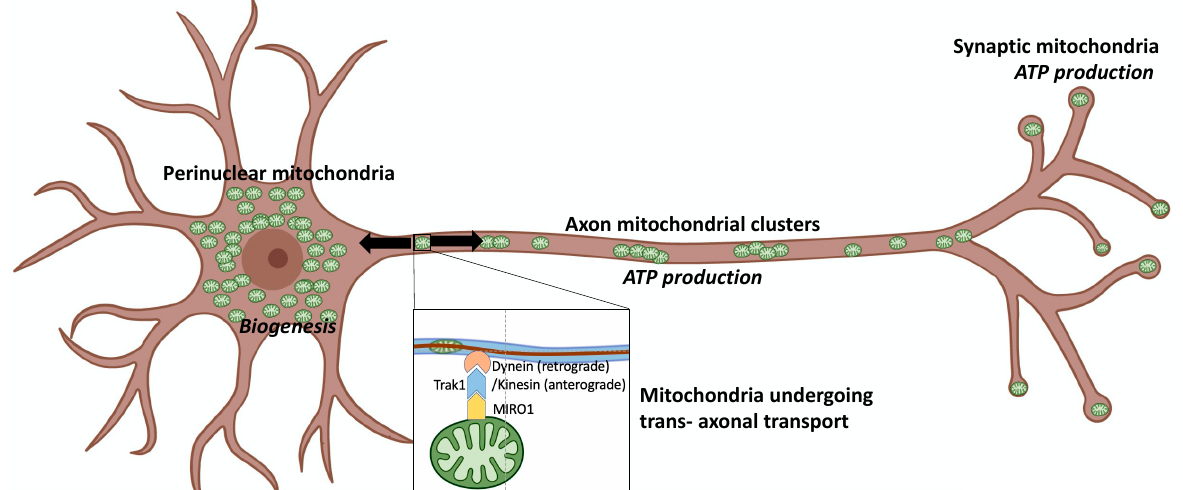
Figure 2. Mitochondrial function and motility are defined by subcellular location in neurons. Schematic depicts neuronal soma to left, axon in center, and dendrites with synapses to right. Inset shows Miro attaching a mitochondrion, via adaptor protein Trak1, to dynein or kinesin motor proteins for transport along axonal microtubules.